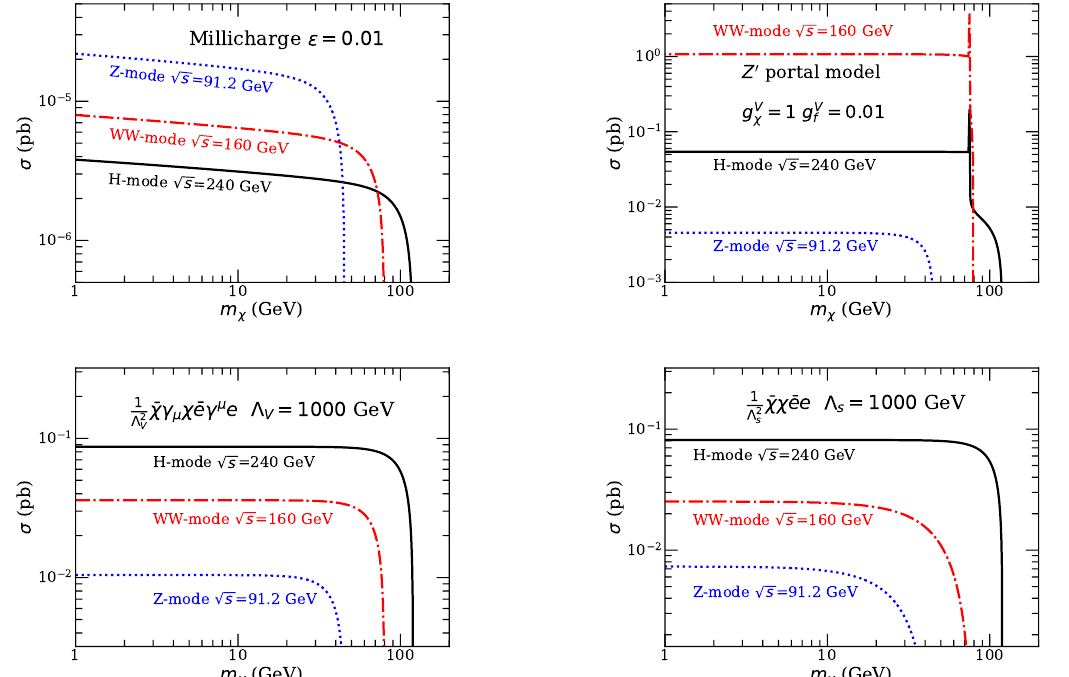
Figure 2 . Total monophoton cross section (cid:27) ( e + e (cid:0) ! (cid:31) (cid:22) (cid:31)(cid:13) ) at CEPC in millicharged DM models (upper left panel), in Z 0 portal DM models (upper right panel), and with DM e(cid:11)ective operators (lower two panels). For the millicharged DM models, we use " = 0 : 01 here. For the Z 0 portal DM models, we use M Z 0 = 150 GeV, g f = 0 : 01, and g (cid:31) = 1 in the vector coupling only case. For the V V DM e(cid:11)ective operators, we use (cid:3) = 1000 GeV. The three di(cid:11)erent running modes are